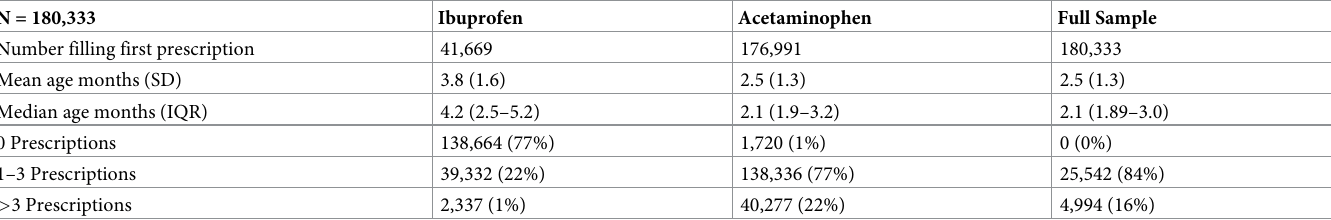
Table 2. Demographic description of the sample. SD; standard deviation, IQR; interquartile range.